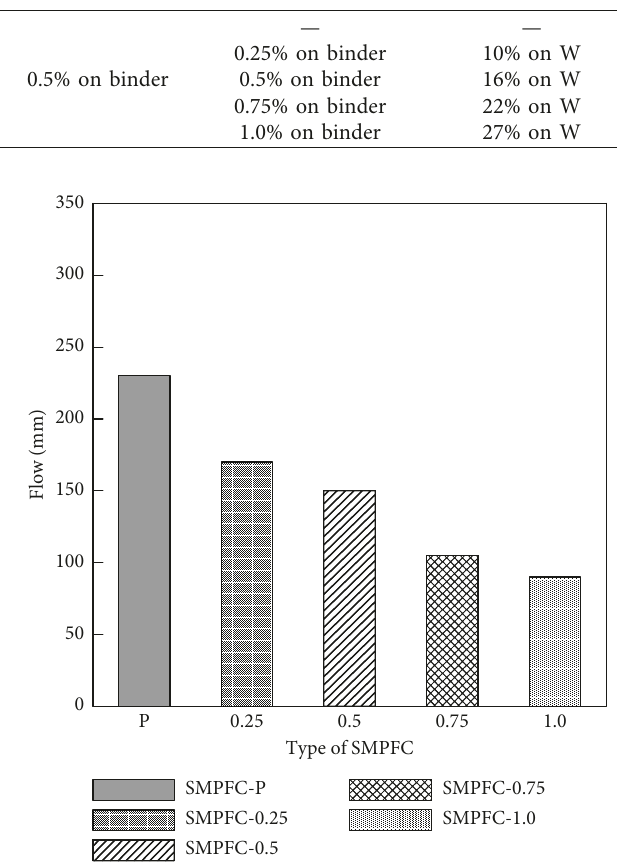
Figure 1: Test results of flow (extra water not